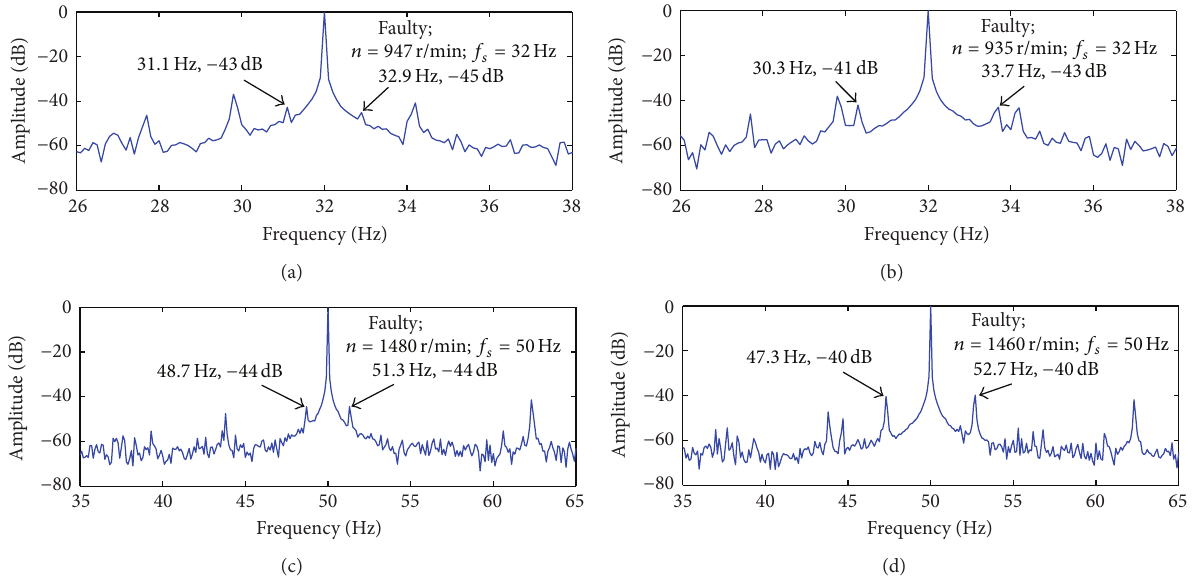
Figure 10: Power spectrum of the stator current around (left) 25% and (right) 50% full loads. Top row: 32 Hz and bottom row: 50 Hz reference